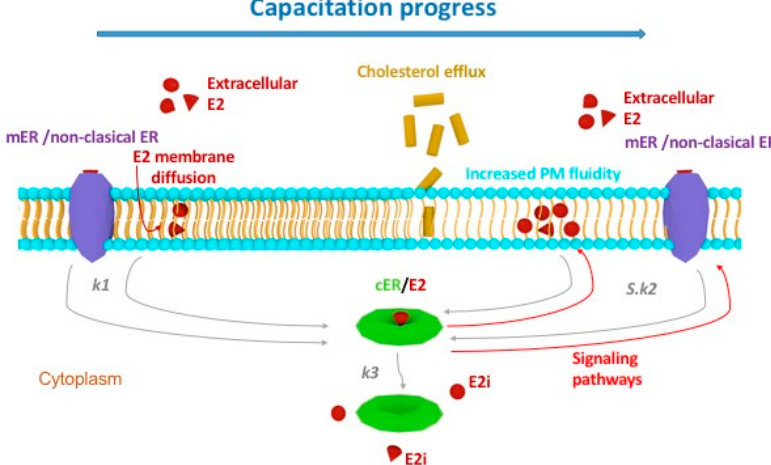
Figure 8. Schematic interpretation of kinetic analysis results applied on estradiol sperm action using the symbols from kinetic equations. The model depicts capacitating progress in time (blue arrow), which is represented by plasma membrane (PM) reorganization and increasing fluidity. During this process, the PM becomes more receiving for extracellular estradiol E2, which is passing via diffusion after its initial adsorption onto specific PM adsorbents, such as mERs and/or non-classical ER. Kinetic analysis of biological data suggests the formation of an adduct cER/E2 in the cytoplasm with the rate constant k 1 (grey arrows), which, when formed, serves as an autocatalytic agent, signalling an increase in PM fluidity directed by S · k 2 (red arrows). This signalling event is accompanied by the complex cER/E2 disintegration characterized by the rate constant k 3 (grey arrow) and a release of estradiol E2 i remaining in the cytoplasm. The cERs remain internalized within the cytoplasm; however, they lose their receptivity and remain